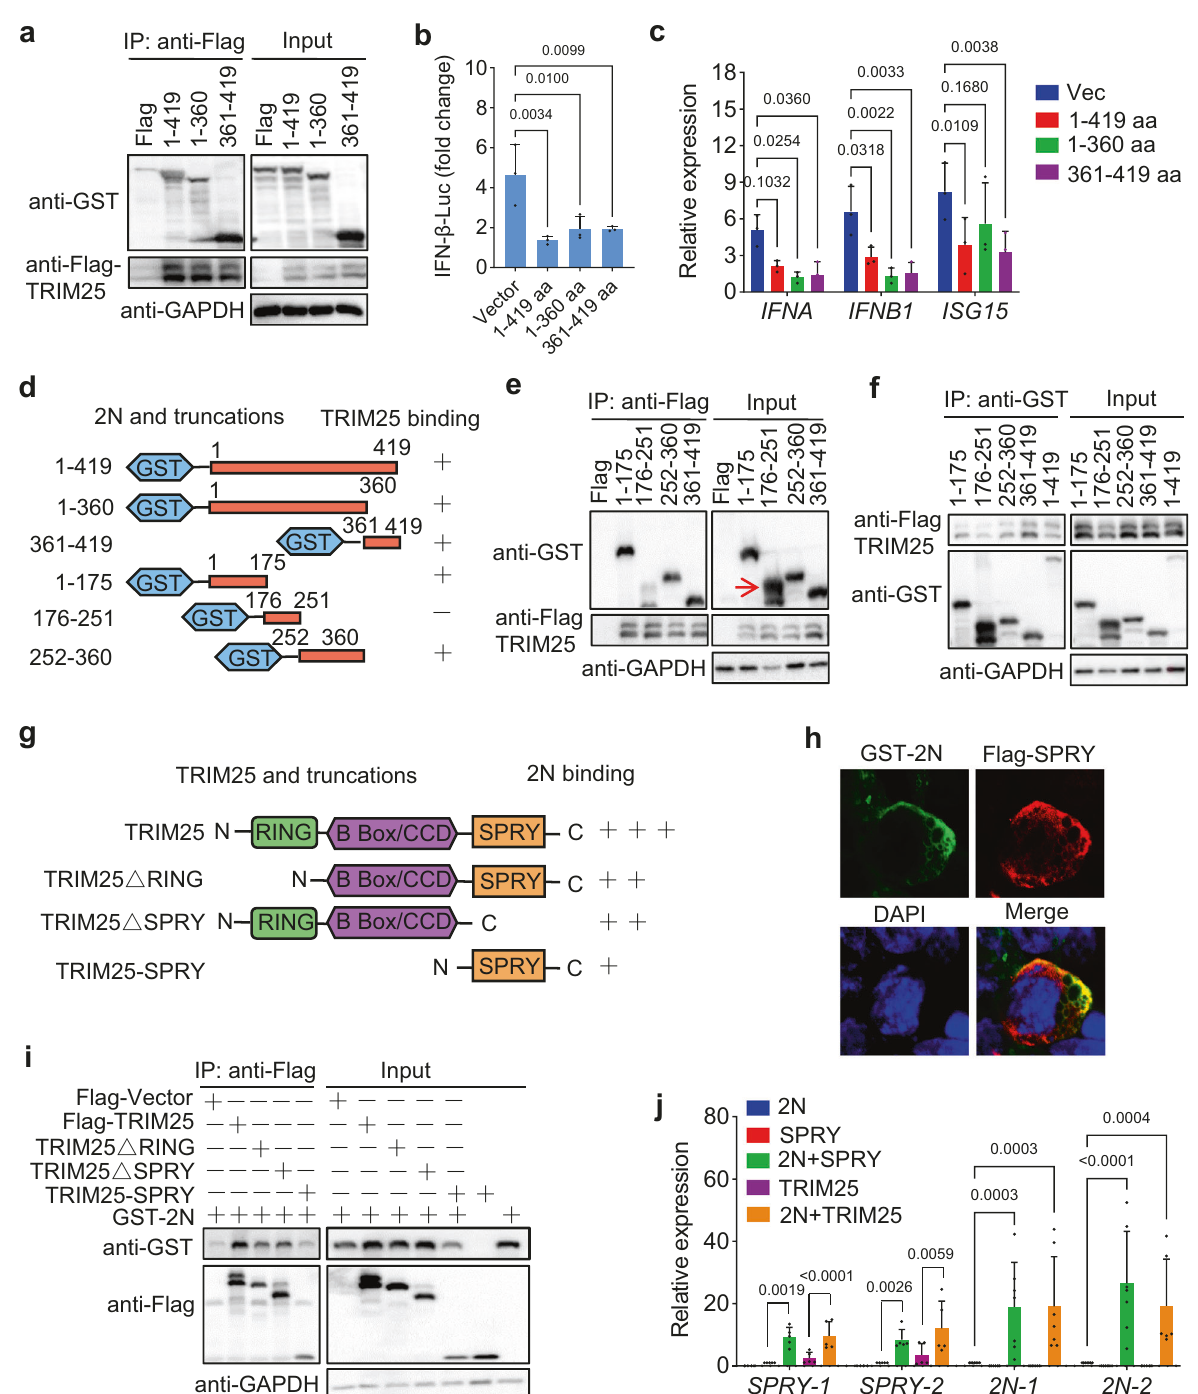
Fig. 7 The interaction domains of 2N protein and TRIM25. a HEK293T cells were transfected with the plasmids expressing GST-tagged full- length or truncated SARS-CoV-2 N (2N) protein, together with Flag-TRIM25 or Flag-vector. At 24 hpt, anti-Flag immunoprecipitates were analyzed by immunoblot with anti-GST and Flag antibodies. b , c HEK293T cells were transfected with an IFN- β promoter reporter and the full- length or truncated 2N plasmids, then treated with poly (I:C). At 24 hpt, luciferase activity was measured ( b ), and the mRNA expression of IFNA , IFNB1 , and ISG15 were examined using qPCR ( c ). d Domain mapping of the SARS-CoV-2 N and TRIM25 association. e HEK293T cells were transfected with the indicated GST-tagged truncations of 2N and Flag-TRIM25 or Flag-vector. At 24 hpt, anti-Flag immunoprecipitates were analyzed by immunoblot. The arrow indicates the target protein band. f HEK293T cells were transfected with the GST-tagged truncations of 2N and Flag-TRIM25. At 24 hpt, the cell lysates were incubated using Glutathione Agarose to purify GST-S-2-N truncations. The puri fi ed proteins were analyzed by immunoblot. g Domain mapping of the association. h HEK293T cells were transfected with plasmids expressing GST-2N and Flag-TRIM25-SPRY domain. At 24 hpt, the cells were subjected to immuno fl uorescence analyses with anti-GST and Flag antibodies. i HEK293T cells were transfected with the plasmids expressing Flag-tagged full-length or truncated TRIM25, together with GST-2N. At 24 hpt, anti-Flag immunoprecipitates were analyzed by immunoblot. j HEK293T cells were transfected with the indicated plasmids. At 24 hpt, qPCR examined mRNA expression of SPRY and 2N. Results shown are the mean ± SD of at least three independent